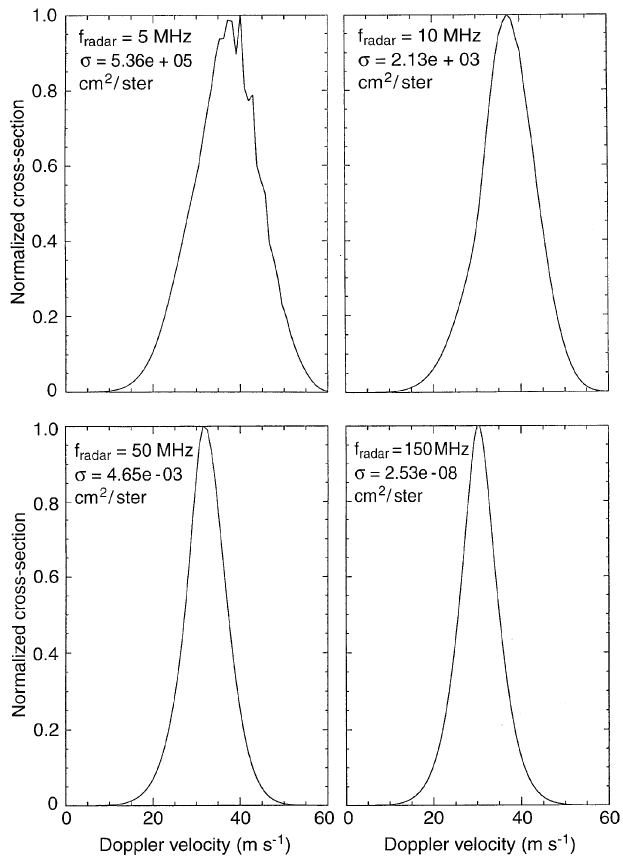
Fig. 2. Normalized differential cross-section as a function of Dop- pler velocity for four different radar frequencies as printed on top of each panel; (cid:112) is the cross-section per unit solid angle obtained by integrating Eq. 1 with respect to (cid:117) , (Eq. 9)